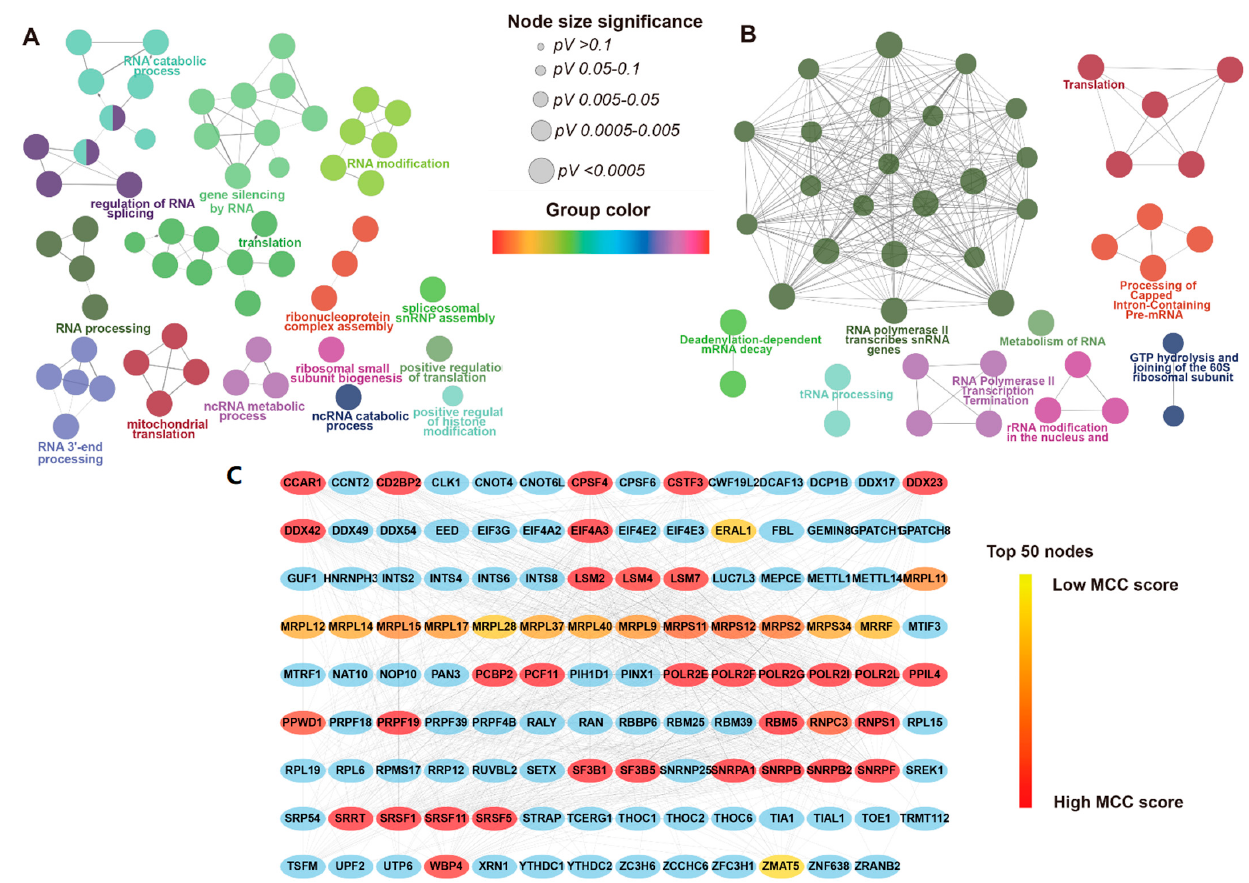
Figure 2. Functional enrichment analysis of DERBPs and PPI Network ( A ). GO terms (biological process) grouped network (kappa score levels ≥ 0.45, p < 0.01). Ellipse represents the GO terms. The node size represents the significance of the term enrichment ( p -value), and the colors represent different functional groups. ( B ). The REACTOME pathway grouped network (kappa score levels ≥ 0.45, p < 0.01). Ellipse represents the GO terms. The node size represents the significance of the term enrichment ( p -value), and the colors represent different functional groups. ( C ). The MCC score of top 50 genes in the PPI network of DERBPs (combined score ≥ 0.7) is represented by a red to yellow gradient.